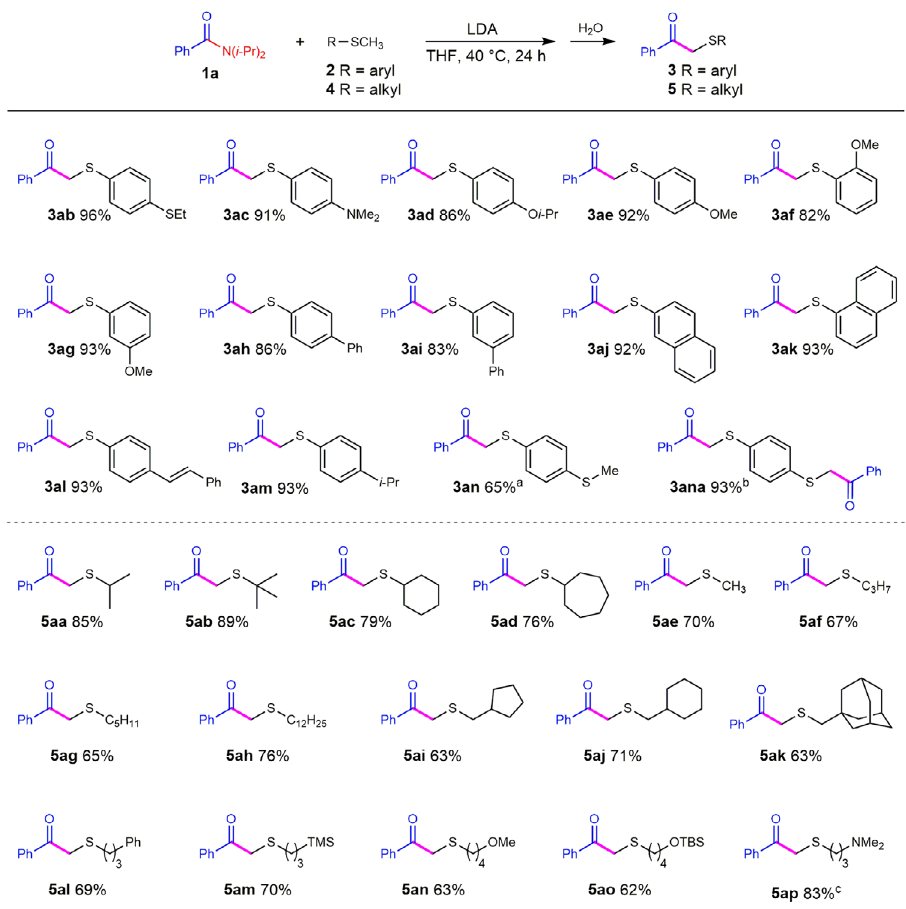
Fig. 2 Scope of Methyl Sul fi des. Conditions: for thioanisoles, benzamide 1a (0.5 mmol), 2 (0.7 mmol), LDA (0.55 mmol), THF (1 mL), 40 °C, 24 h; for alkyl methyl sul fi des, benzamide 1a (0.5 mmol), 4 (1.25 mmol), LDA (0.75 mmol), THF (1 mL), 40 °C, 24 h. a Di-benzoylation product 3ana was obtained as by- product (26% yield). b Benzamide 1a (0.9 mmol), 1,4-bis(methylthio)benzene 2n (0.3 mmol), LDA (0.66 mmol), yield based on 2n . c 60